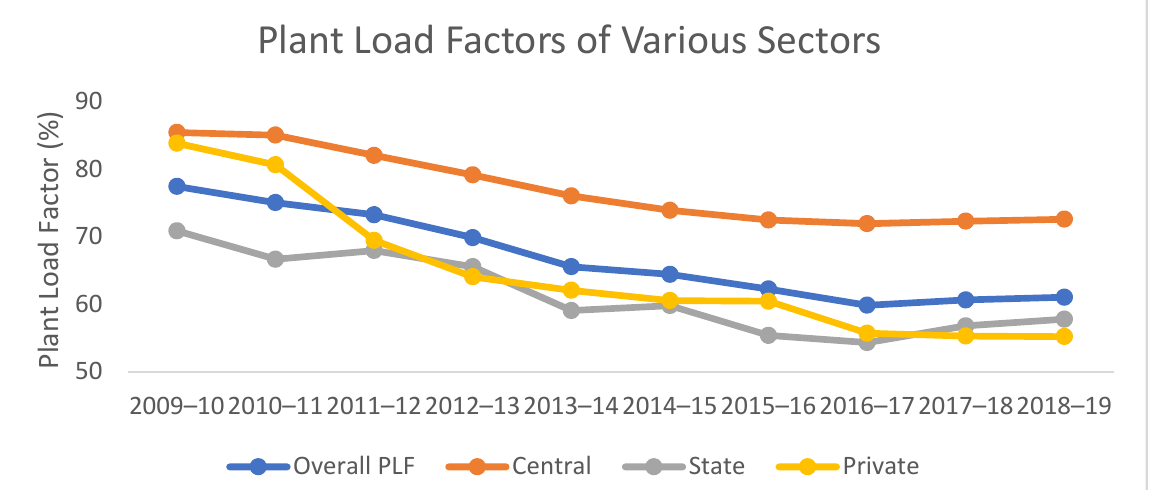
Figure 1. Plant load factors of various sectors in India.